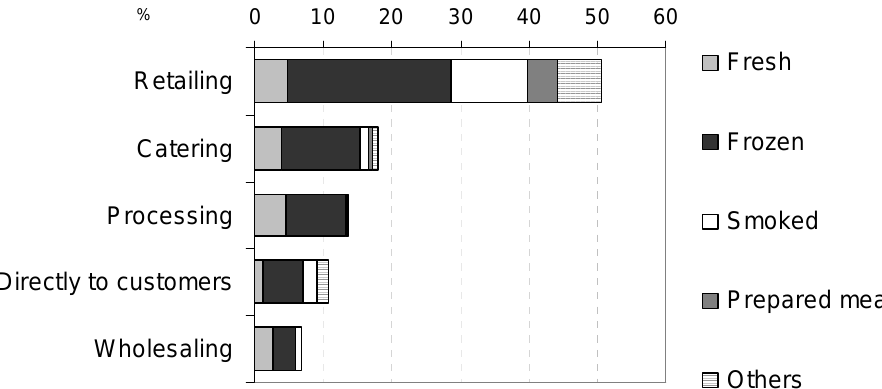
Fig. 2. Sales of reindeer meat by product group and selling